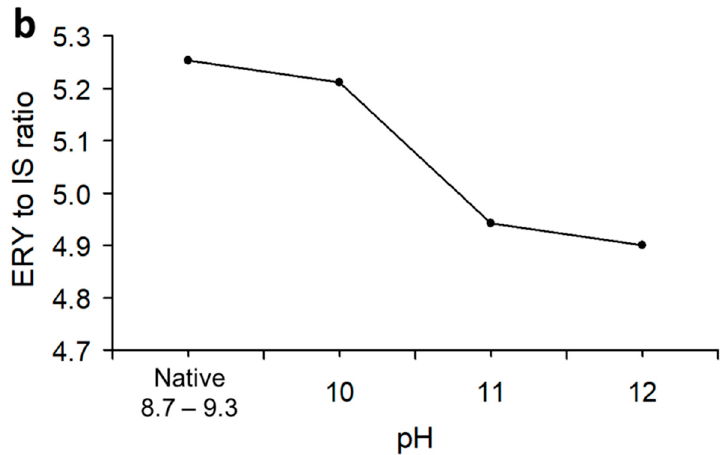
Figure 2. Effect of the ( a ) buffer concentration and ( b ) pH on the rate of the derivatization reaction between DEPC and ERY.